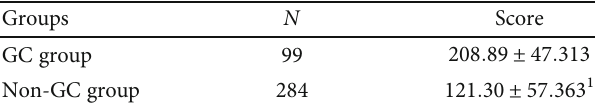
Figure 2: ROC curve of the validation group.